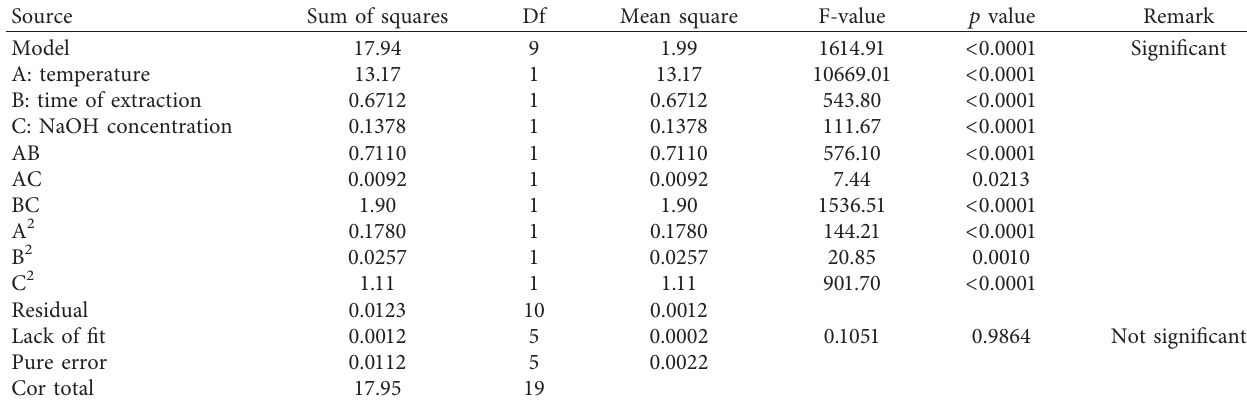
Table 5: ANOVA fit for yield of crude extracts.